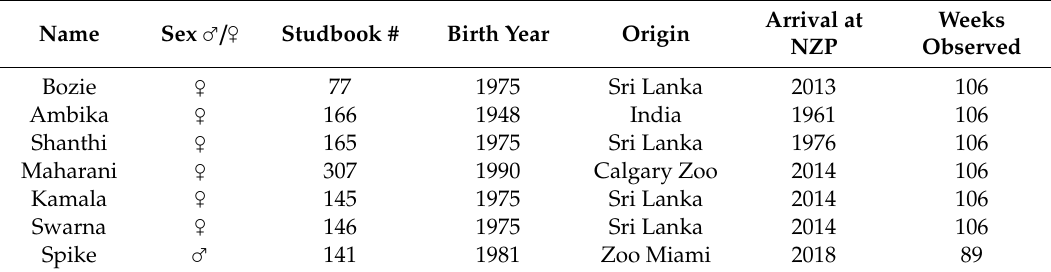
Table 1. Life history summary of the seven Asian elephants evaluated in the study at the Smithsonian National Zoological Park